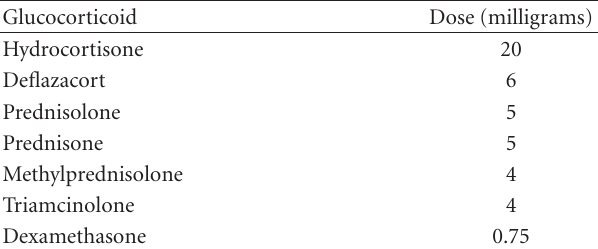
Table 3: Equivalent doses of